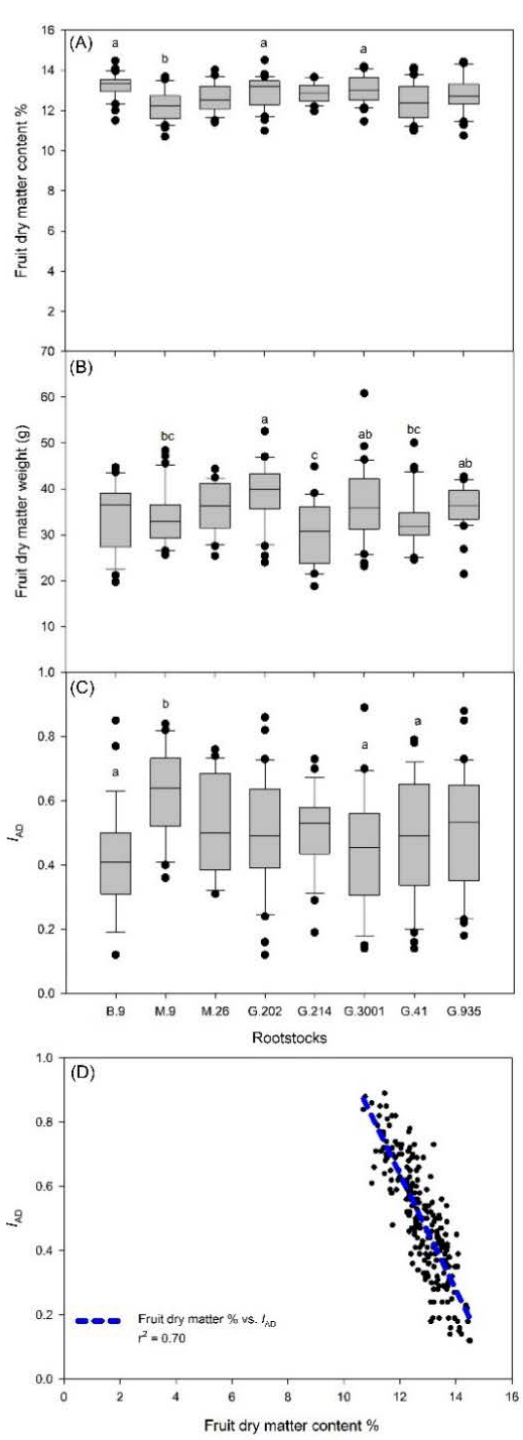
Figure 4. Fruit dry matter content percent DM% ( A ), fruit dry matter weight ( B ), absorbance difference index I AD of fruit skin ( C ), and, the DM%— I AD relation (D) of Honeycrisp apples on eight rootstocks in 2019. In ( A – C ), different letters indicate significant difference amongst the rootstocks ( p ≤ 0.05, ANOVA, Tukey–Kramer Pairwise Comparisons; n = 30; G.202: 6 apples per tree, n = 5; G.3001: 10 apples per tree, n = 3; other rootstocks: 5 apples per tree, n = 6). In ( D ), the blue dash line stands for linear regression between DM% and I AD of 240 fruits from eight rootstocks.